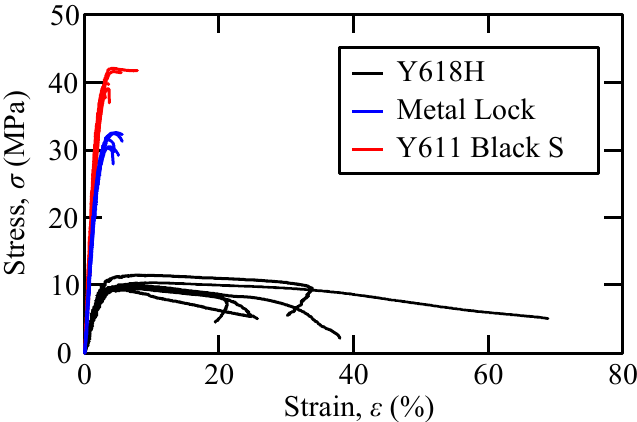
Figure 4. Stress–strain curves of Y618H, Metal Lock, and Y611 Black S adhesive. Table 1. Mechanical properties of Y618H, Metal Lock, and Y611 Black S adhesive (standard devia- tion is mentioned in parentheses).